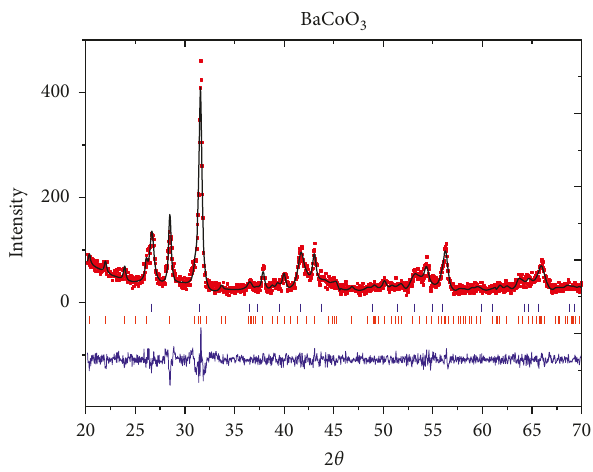
Figure 3: X-ray diffraction pattern and its matching refinement plot of BaCoO 3 , interpreted as a mixture of BaCoO 3 and BaCoO 2.61 : observed X-ray diffraction intensity (points) and calculated curve (line). The bottom curve is the difference of patterns, y obs the small bars indicate the angular positions of the allowed Bragg